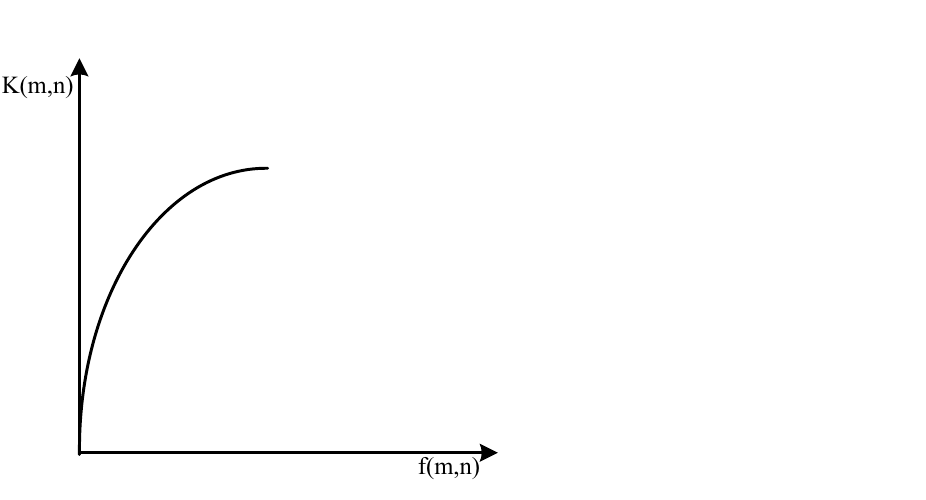
Figure 5. Log-transformed image.